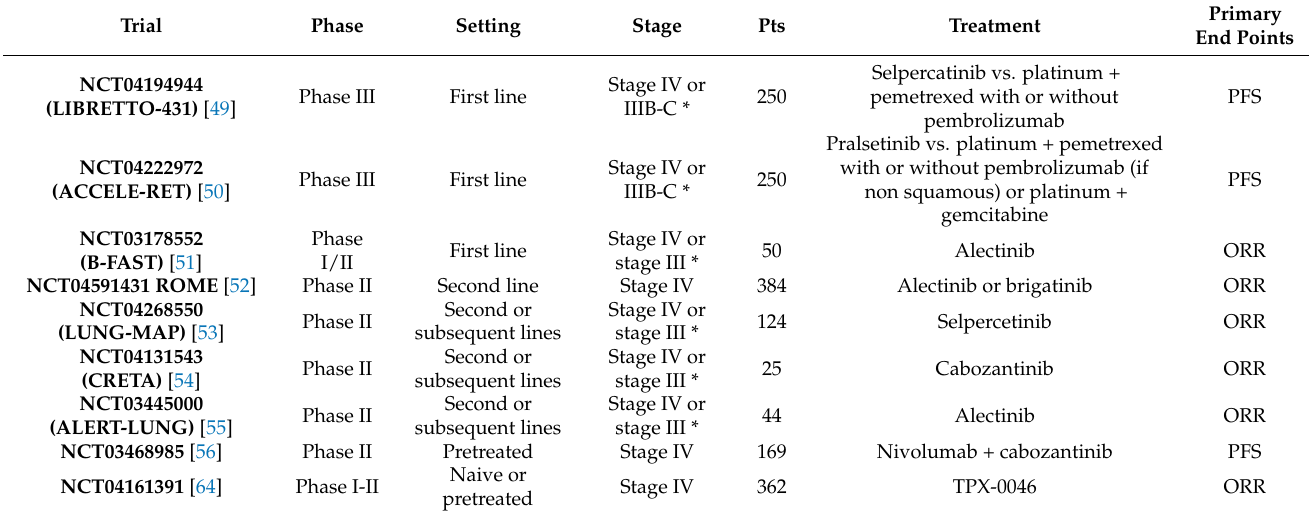
Table 3. Ongoing trials with RET inhibitors in RET positive NSCLC patients. Trial